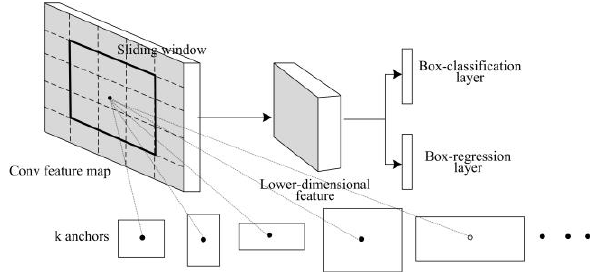
Figure 3. Schematic diagram of the RPNs.